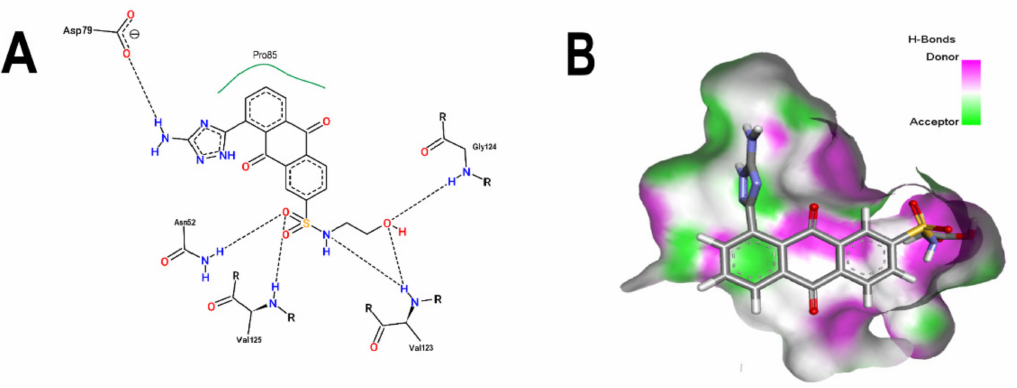
Figure 4. Analysis of the best pose of ATD (aminotriazole anthraquinone derivative). ( A ) 2D interaction diagram of the 3ZKBL-ATD complex. ( B ) 3D representation of hydrogen bond surface of 3ZKBL in complex with ATD. 2D interaction diagram was performed with PoseView. 3D hydrogen bond surface representation was performed with Discovery Studio Visualizer.